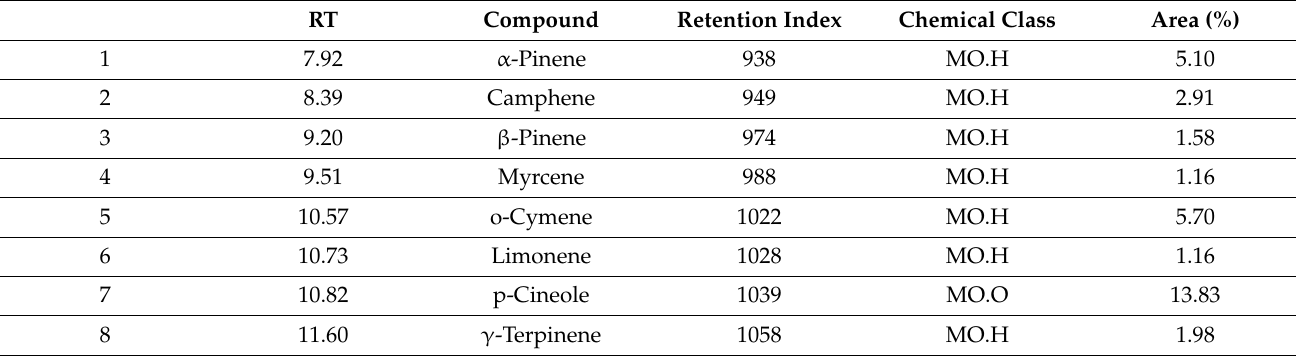
Figure 1. Chromatographic profile of EOAG by GC/MS. Table 1. Volatile compounds of EO identified by GC/MS.